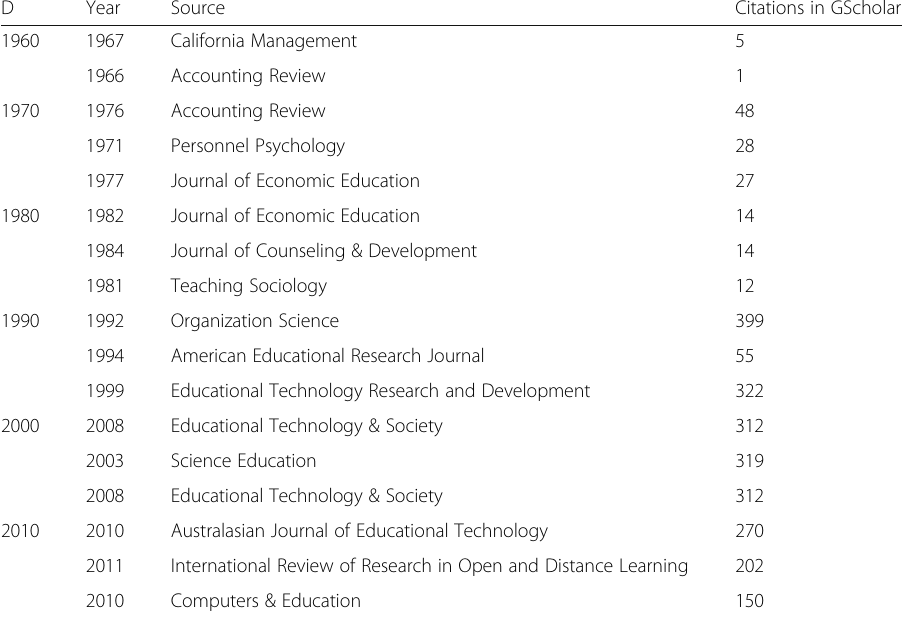
Table 3 Final sample analysed: decade, year, source and number of citations D Year Source Citations in